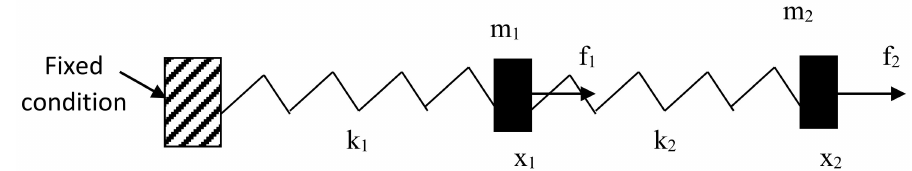
Figure 1. A system with two degrees of freedom (DOF).